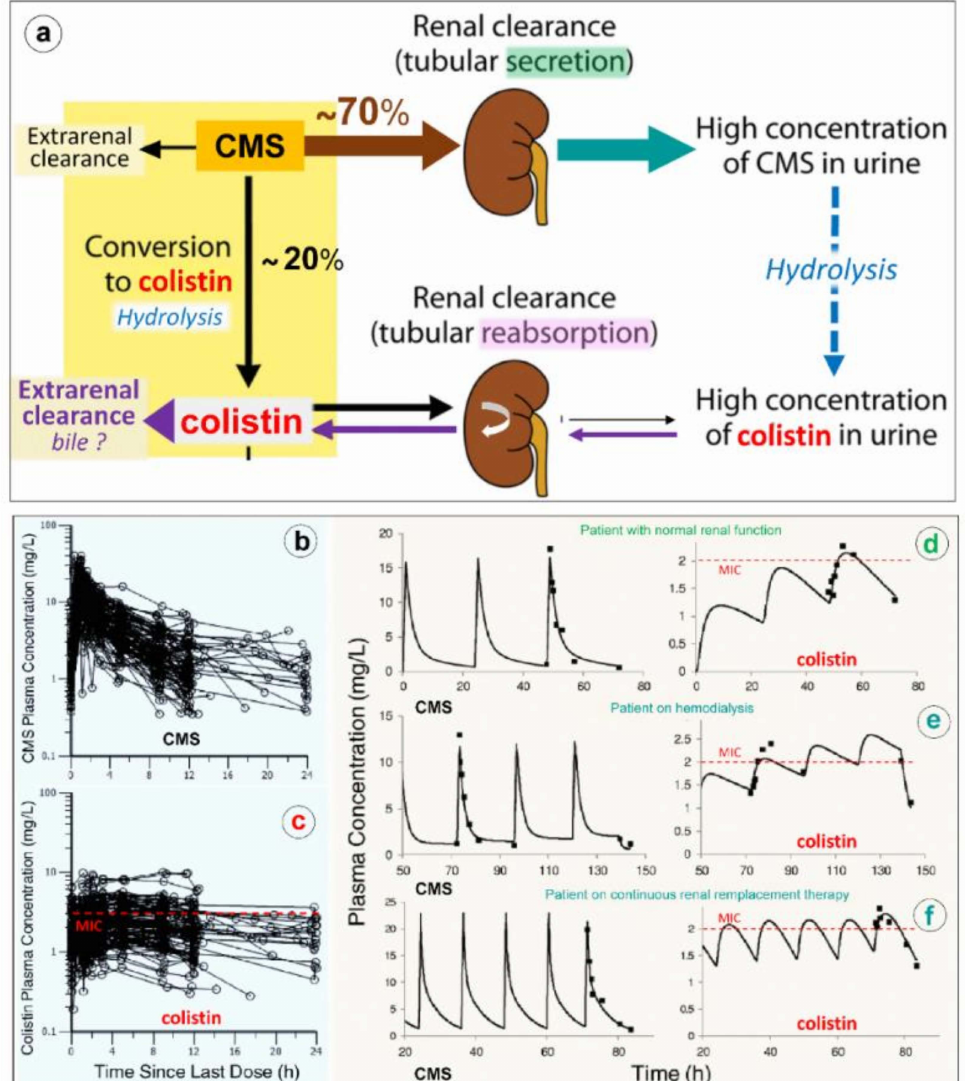
Figure 6. Elimination and pharmacokinetics of colistimethate sodium (CMS) and colistin. ( a ) Schematic representation of elimination pathways for CMS and colistin. Arrow thickness indicates the relative magnitude of each pathway when kidney function is normal. CMS includes all partially methanesulfonated derivatives of colistin. After intravenous administration of CMS, extensive renal excretion occurs, with some of the excreted CMS being converted to colistin within the urinary tract. Colistin is massively reabsorbed by renal tubules and likely excreted in the biliary tract [63]. ( b , c ) Plasma concentration time profiles of CMS (Figure 6b) and formed colistin (Figure 6c) with 105 critically ill patients who were treated by intravenous CMS for blood stream infection or pneumonia caused by multidrug-resistant Gram-negative bacteria (89 not on renal replacement, 12 on intermittent hemodialysis and 4 on continuous renal replacement therapy). Doses of replacement therapy ( d – f ). The dashed line indicates the minimum inhibitory concentrations of susceptible strains